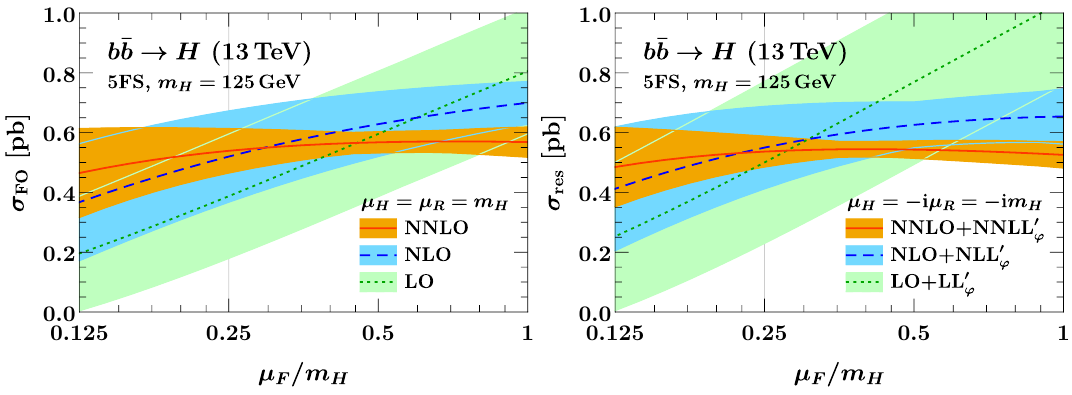
Figure 7 . The total b (cid:22) b ! H cross section at (cid:22) FO = (cid:22) R = m H as a function of the central choice for (cid:20) F = (cid:22) F =m H . The (cid:12)xed-order results are shown on the left and the resummed results on the right. We also include the (cid:1) b uncertainty from the low-scale matching onto the b -quark PDF. The uncertainty bands show (cid:1) (cid:22) ((cid:12)xed order) and (cid:1) (cid:22) (cid:8) (cid:1) ’